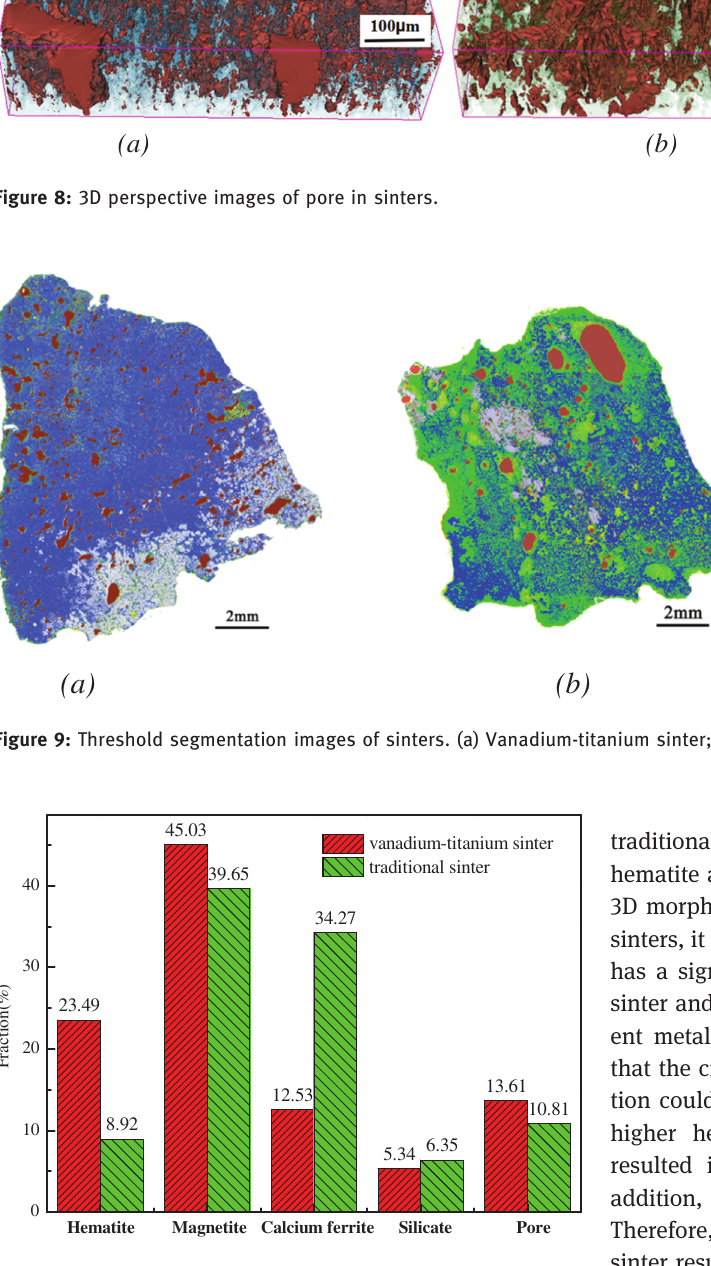
Figure 10: Calculated fraction of minerals in the two sinters.